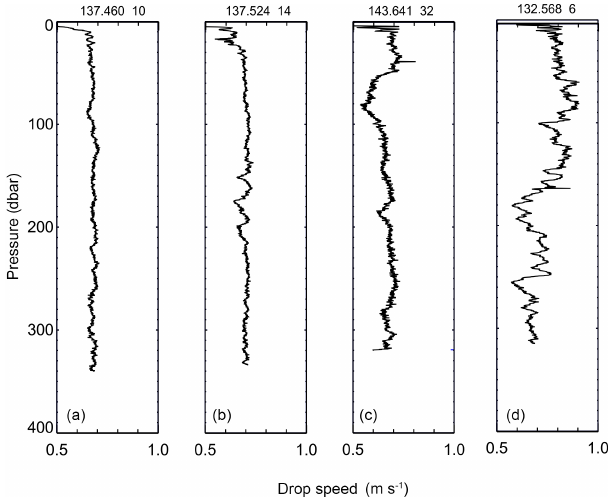
Figure 3. Profiler drop speed from a number of example profiles (time and profile number on